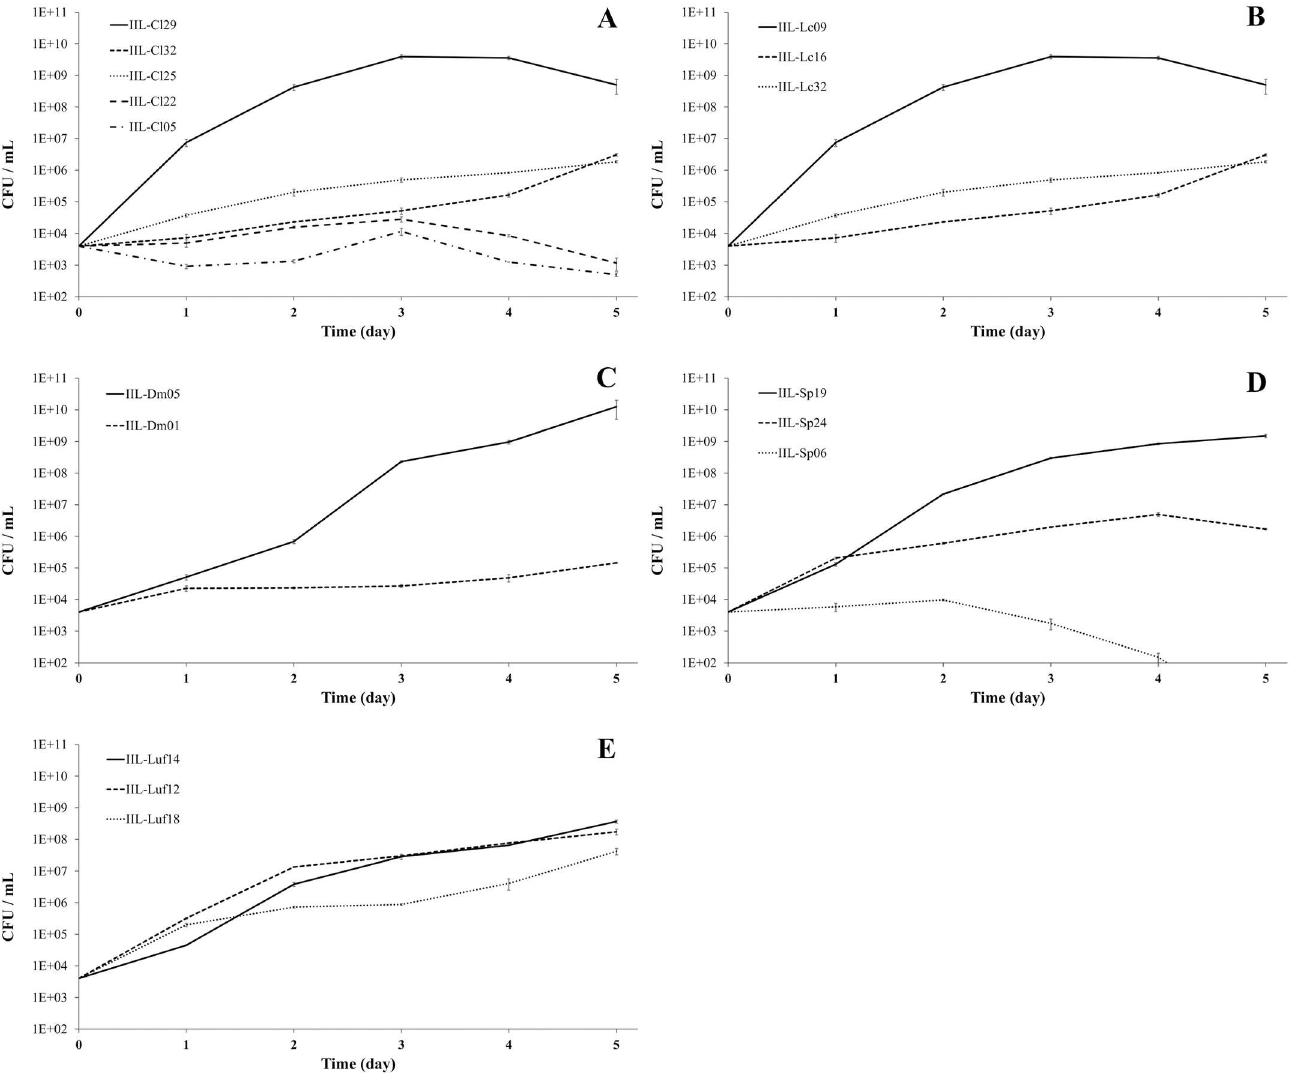
Fig 3. Growth of insecticide-degrading bacterial isolates obtained from the gut microbiota of strain of Spodoptera frugiperda resistant to the insecticides chlorpyrifos ethyl (A), lambda-cyhalothrin (B), deltamethrin (C), spinosad (D), and lufenuron (E) when cultured in minimum medium M9 added of 10 μ g/mL of the insecticide the host insect strain was resistant